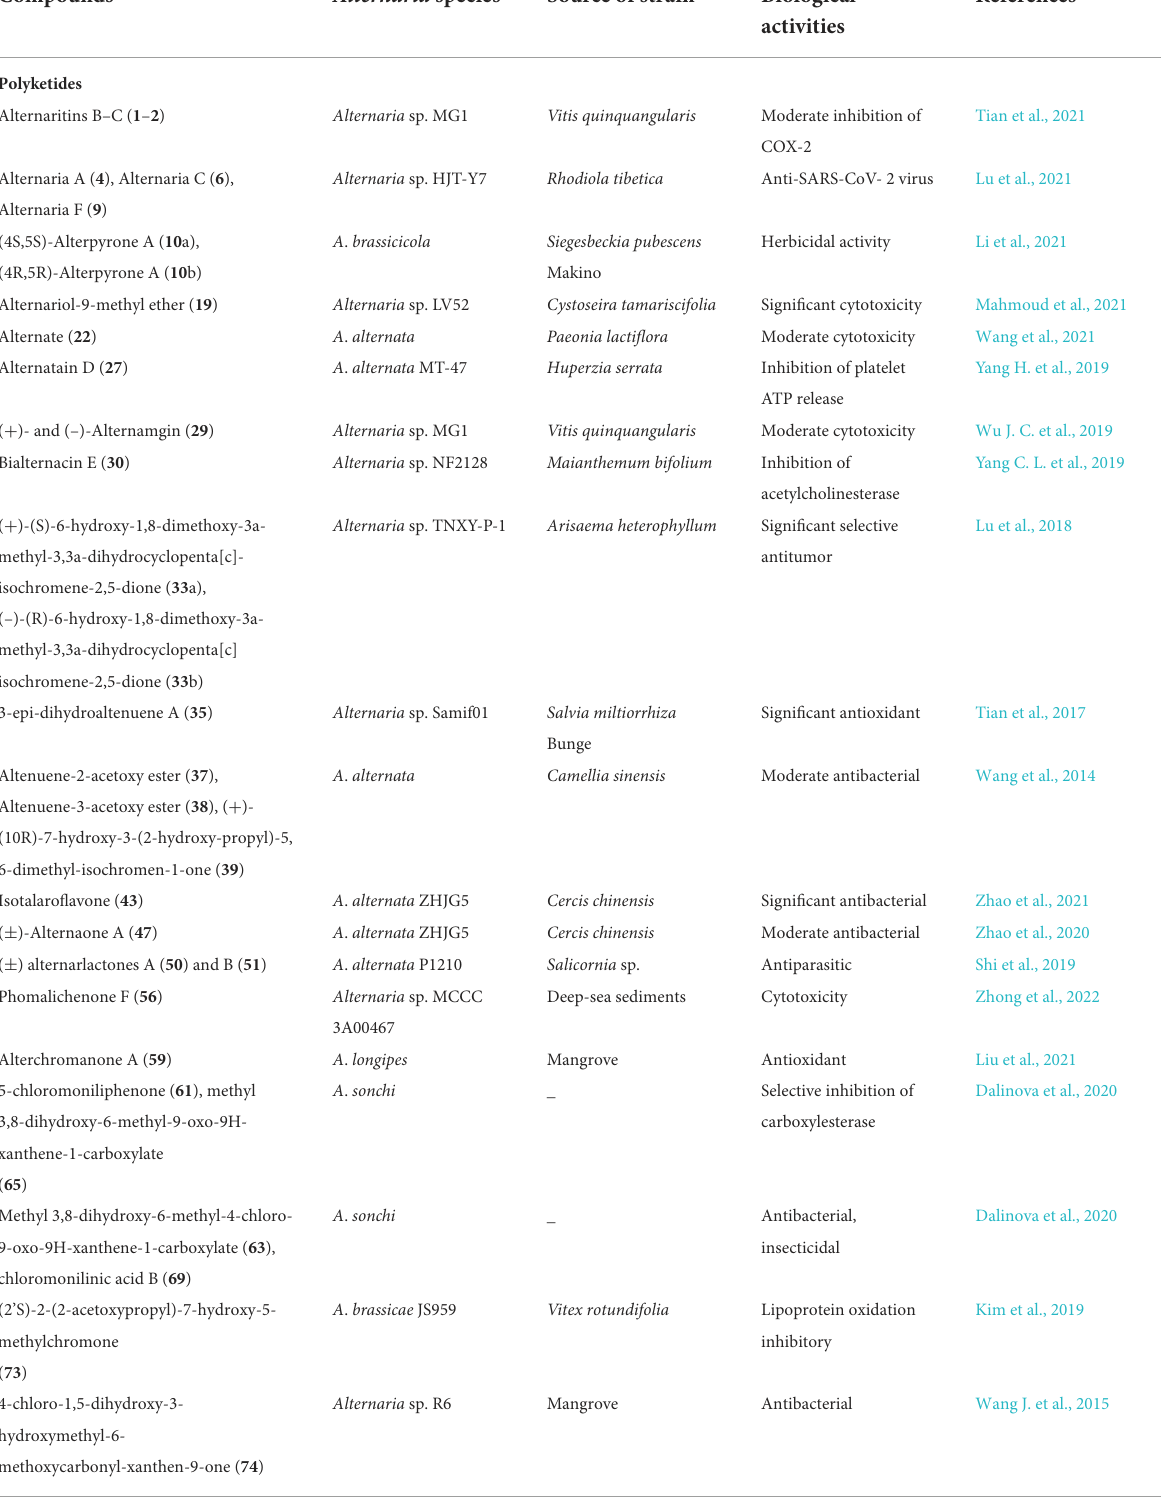
TABLE 1 Bioactivities and sources of secondary metabolites from Alternaria fungi.